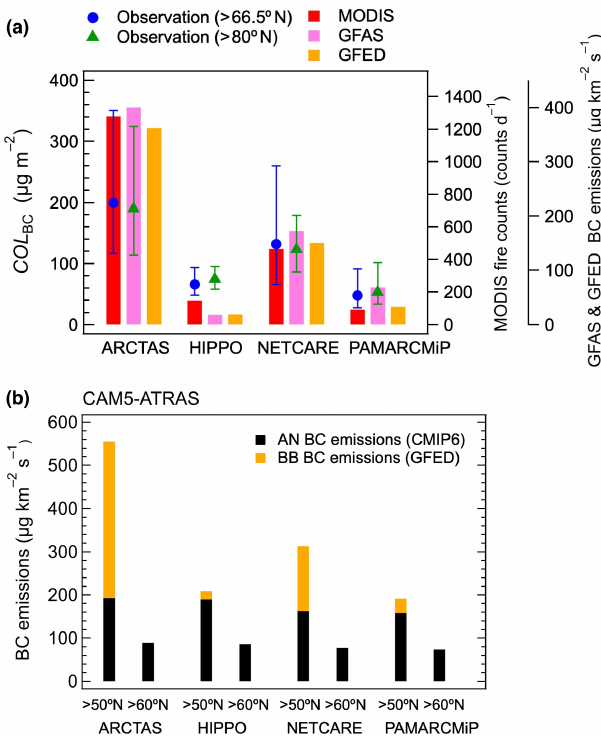
Figure 3. (a) Column amounts of BC mass concentration at alti- tudes between 0 and 5km (COL BC ) at latitudes north of 66.5 ◦ N (blue circles) and 80 ◦ N (green triangles). MODIS-derived fire counts and biomass burning BC emissions compiled in GFAS and GFED datasets are also shown (vertical bars). The fire counts and BC emissions are those at latitudes north of 50 ◦ N for the time period between 14d before the first day of an aircraft experiment and the last day of the experiment. (b) BC emissions used for the CAM5-ATRAS model simulations. Anthropogenic (AN, CMIP6) and biomass burning (BB, GFED) emissions are shown by black and orange colors, respectively. Values at latitudes north of 50 and 60 ◦ N are shown for the time period between 14d before the first day of an aircraft experiment and the last day of the experiment. The BB emissions for > 50 ◦ N are the same as those shown in Fig. 3a. BC emissions used for the MRI-ESM2 model simulations (MAC- City and GFAS) are generally similar to those shown in this figure, although AN emissions for > 60 ◦ N are generally smaller.